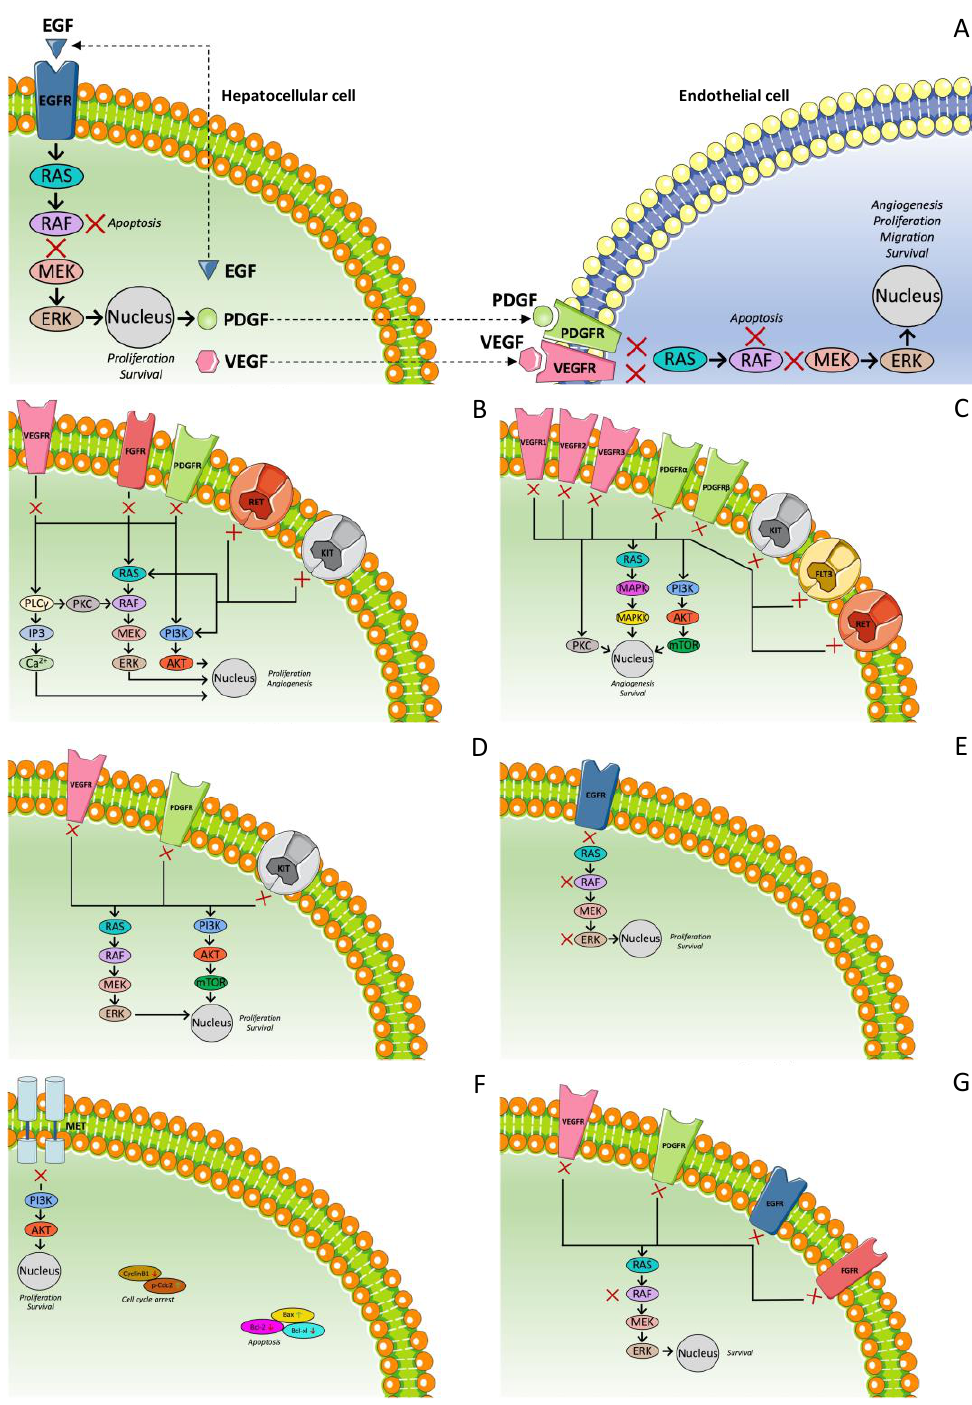
Figure 2. Mechanism of action of multi-targeted tyrosine kinase inhibitor for first-line treatment of HCC. ( A ) Sorafenib; ( B ) lenvatinib; ( C ) sunitinib; ( D ) linifanib; ( E ) erlotinib; ( F ) foretinib; ( G ) do- nafenib.